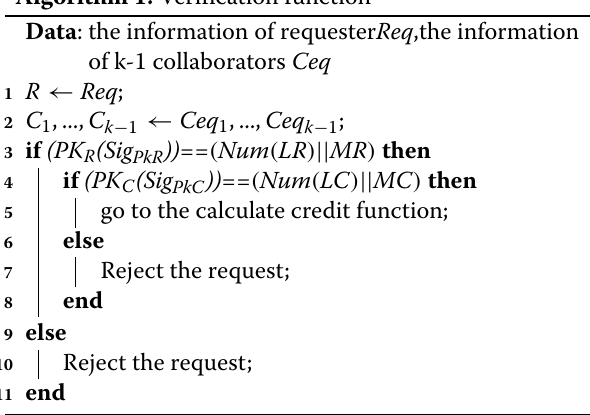
Algorithm 1: Verification